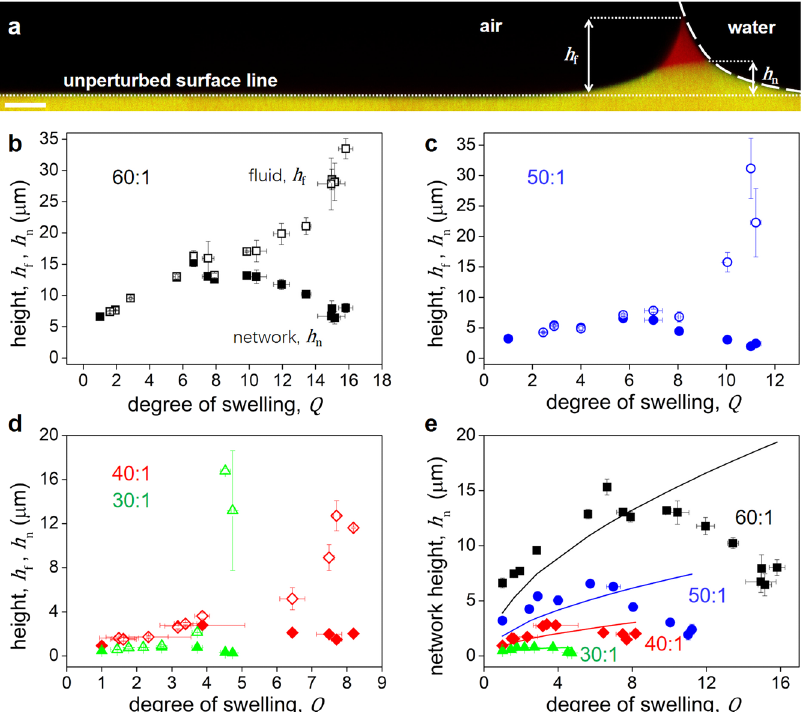
Fig. 5 Quantifying the wetting ridge heights. a Example of a cross-sectional confocal image of a water drop on swollen 60:1 PDMS ( h f and h n are the fl uid and network tip heights relative to the unperturbed surface). Note that several images are stitched together to obtain a larger fi eld of view. Scale bar: 20 µ m. b – d Graphs of fl uid height ( h f , open data points) and network height ( h n , fi lled data points) as a function of the degree of swelling ( Q ) with mixing ratios of ( b ) 60:1, ( c ) 50:1, ( d ) 40:1, and 30:1. e The network height for different degrees of swelling and crosslinking, where the solid curves are predictions given by ≈ γ w sin θ / E . Error bars denote standard deviations.